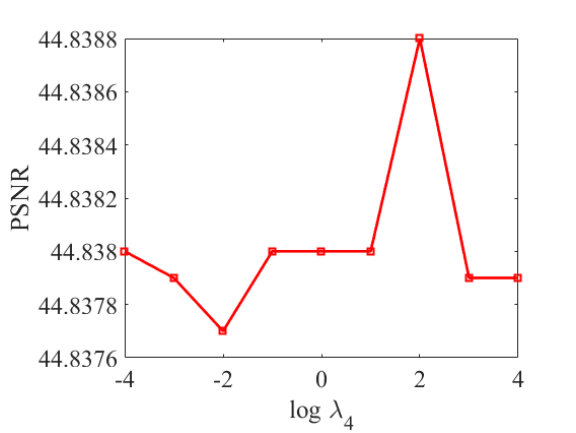
Figure 5. PSNR values for different λ 4